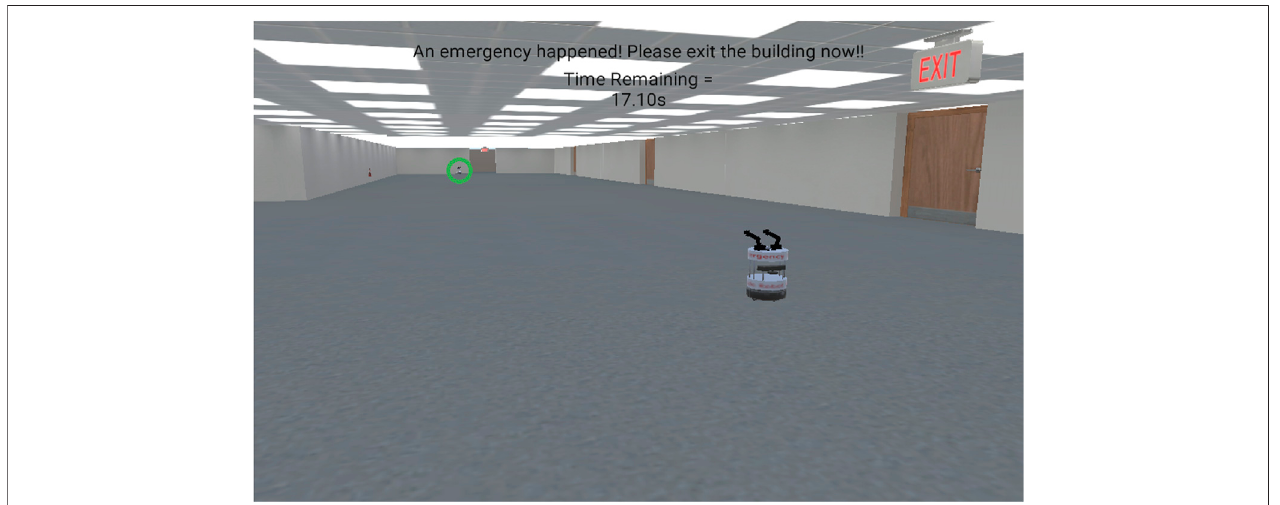
FIGURE 3 | An example of the use of multi-robot handoffs. The nearby robot does not move. It simply directs the subject to the far away robot within the green circle.